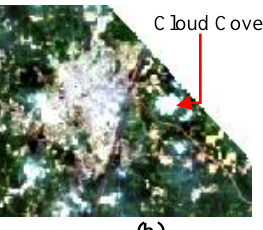
Figure 4: (a) Spectral signature of the cloud covered target and (b) DESIS Scene reference.